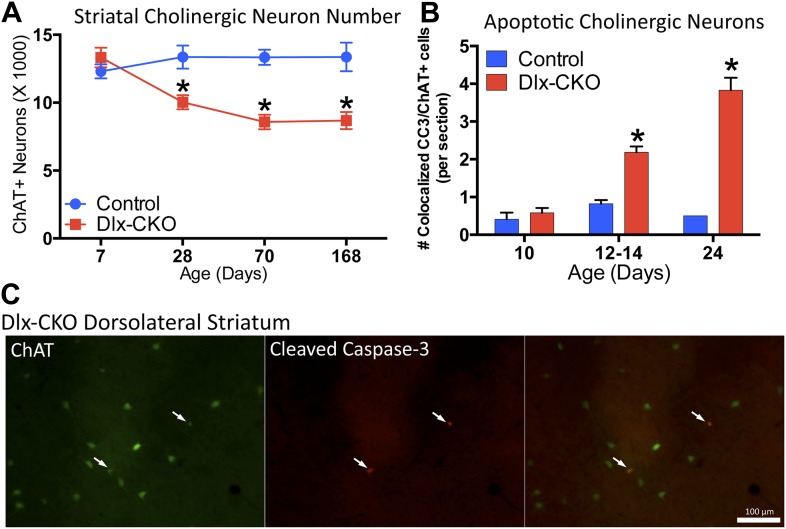
Dlx-CKO LCIs degenerate during juvenile striatal maturation, coincident with the onset of abnormal twisting.(A) Stereological quantification of the number of ChAT-positive neurons in the striata of Dlx-CKO and littermate control mice at time points between postnatal day 7 and 168. Two-way ANOVA main effects of age: F3,66 = 2.899; p = 0.04, genotype: F1,66 = 33.74; p < 0.0001, and interaction: F3,66 = 7.232; p = 0.0003; * represents time points where significant differences exist using Sidak's multiple comparison test. (B, C) Quantification of the number of ChAT-positive striatal neurons co-expressing cleaved caspase-3 between P10 and P24 in control and Dlx-CKO brain sections (two-way ANOVA main effects of age F2,21 = 43.68; p < 0.0001, genotype: F1,21 = 122.1; p < 0.0001, and interaction F2,21 = 32.91; p < 0.0001).